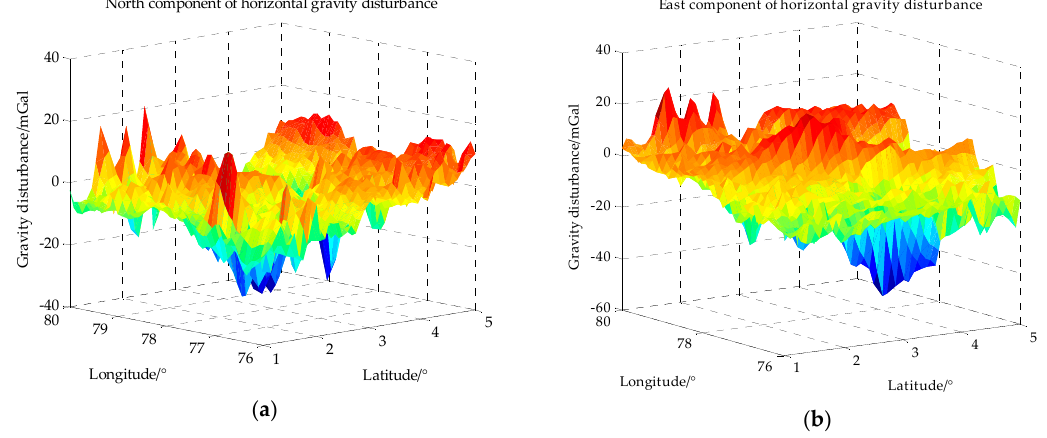
Figure 6. The horizontal gravity disturbance in the simulation area. ( a ) is the north component of the horizontal gravity disturbance and ( b ) is the east component of the horizontal gravity disturbance. (1 mGal = 10 − 5 m/s 2 ).